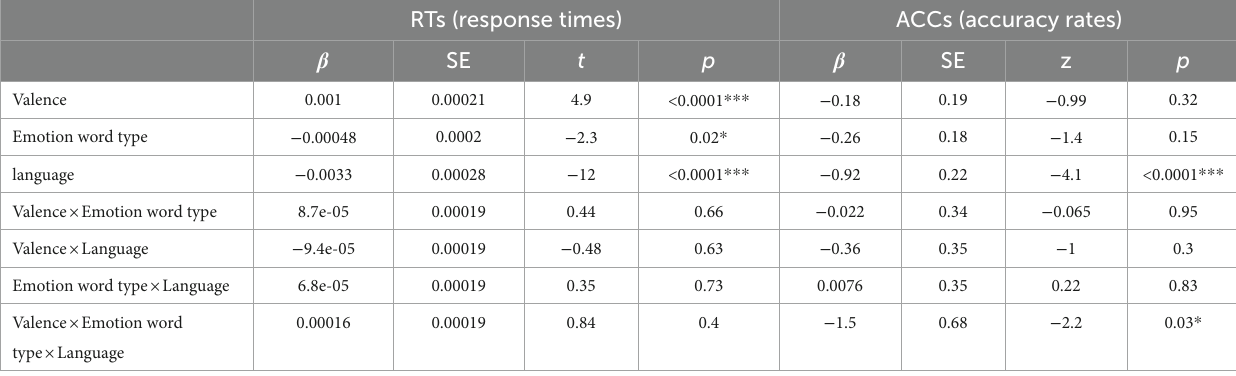
TABLE 5 Statistical analysis of the main effects of and interaction between valence, emotion word type and language reflected in RTs and/or ACCs among the four groups of emotion words in L1 (Chinese) and L2